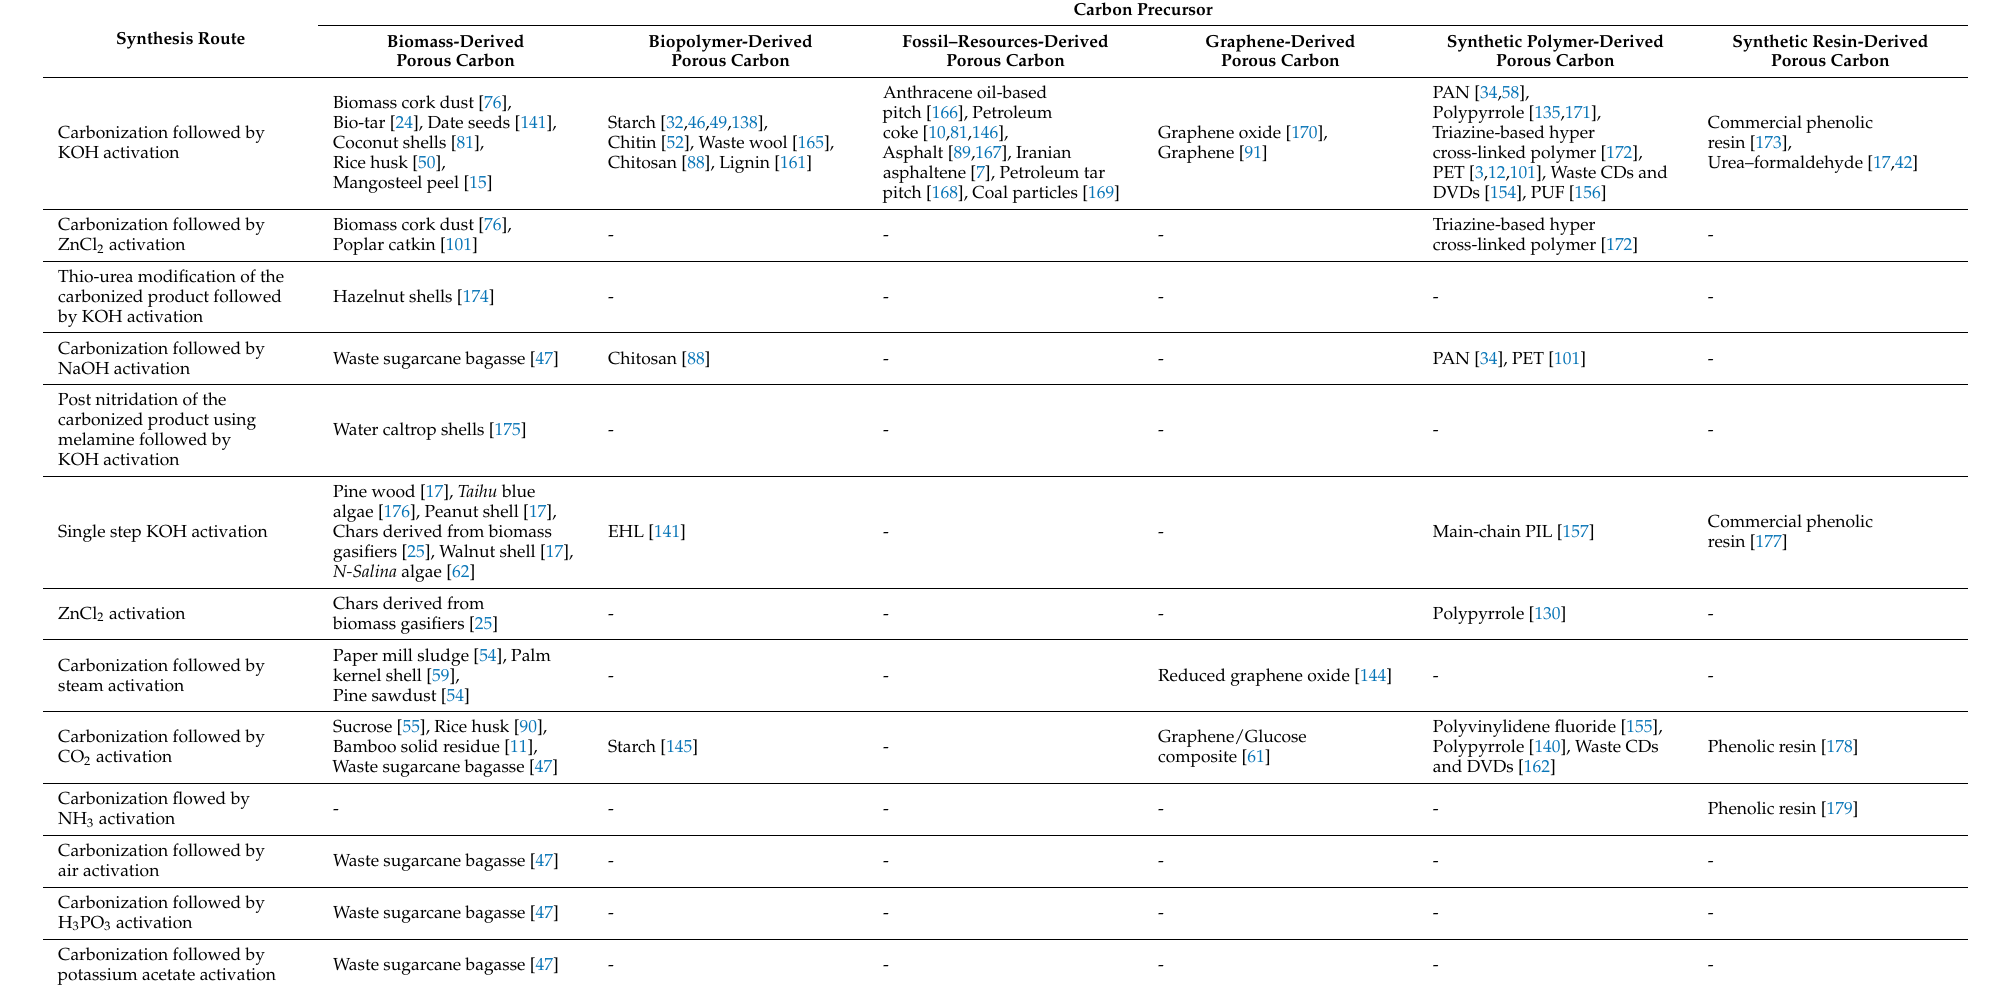
Table 7. Summary of different synthesis routes adopted for porous carbon